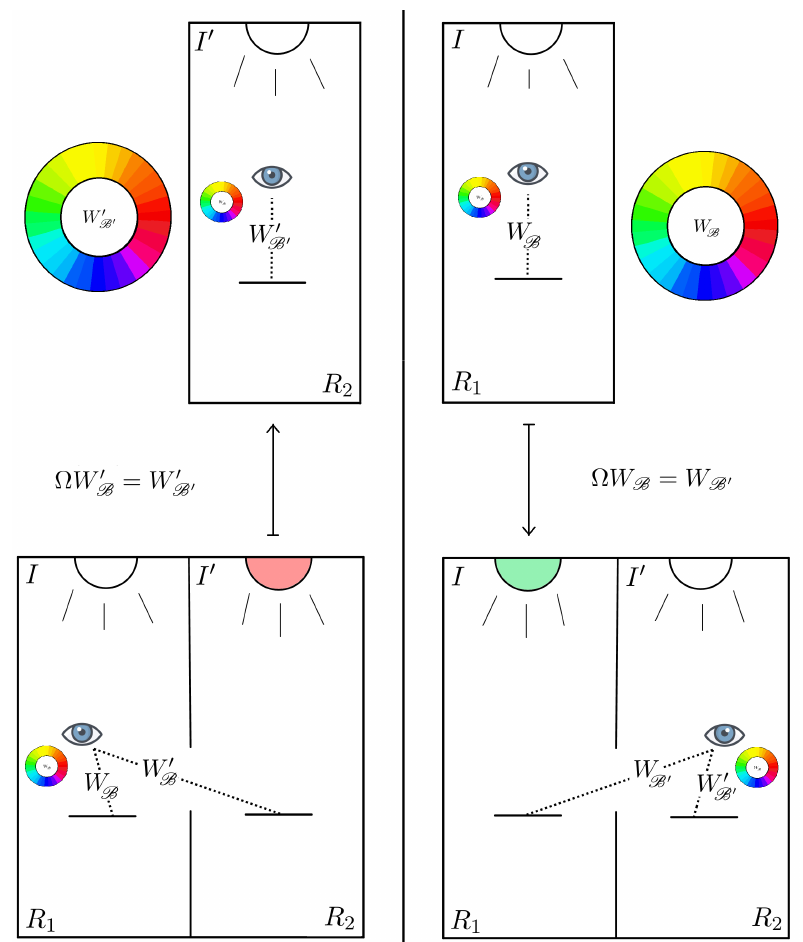
Figure 5. Depiction of Yilmaz’s first experiment with the notation established in Section